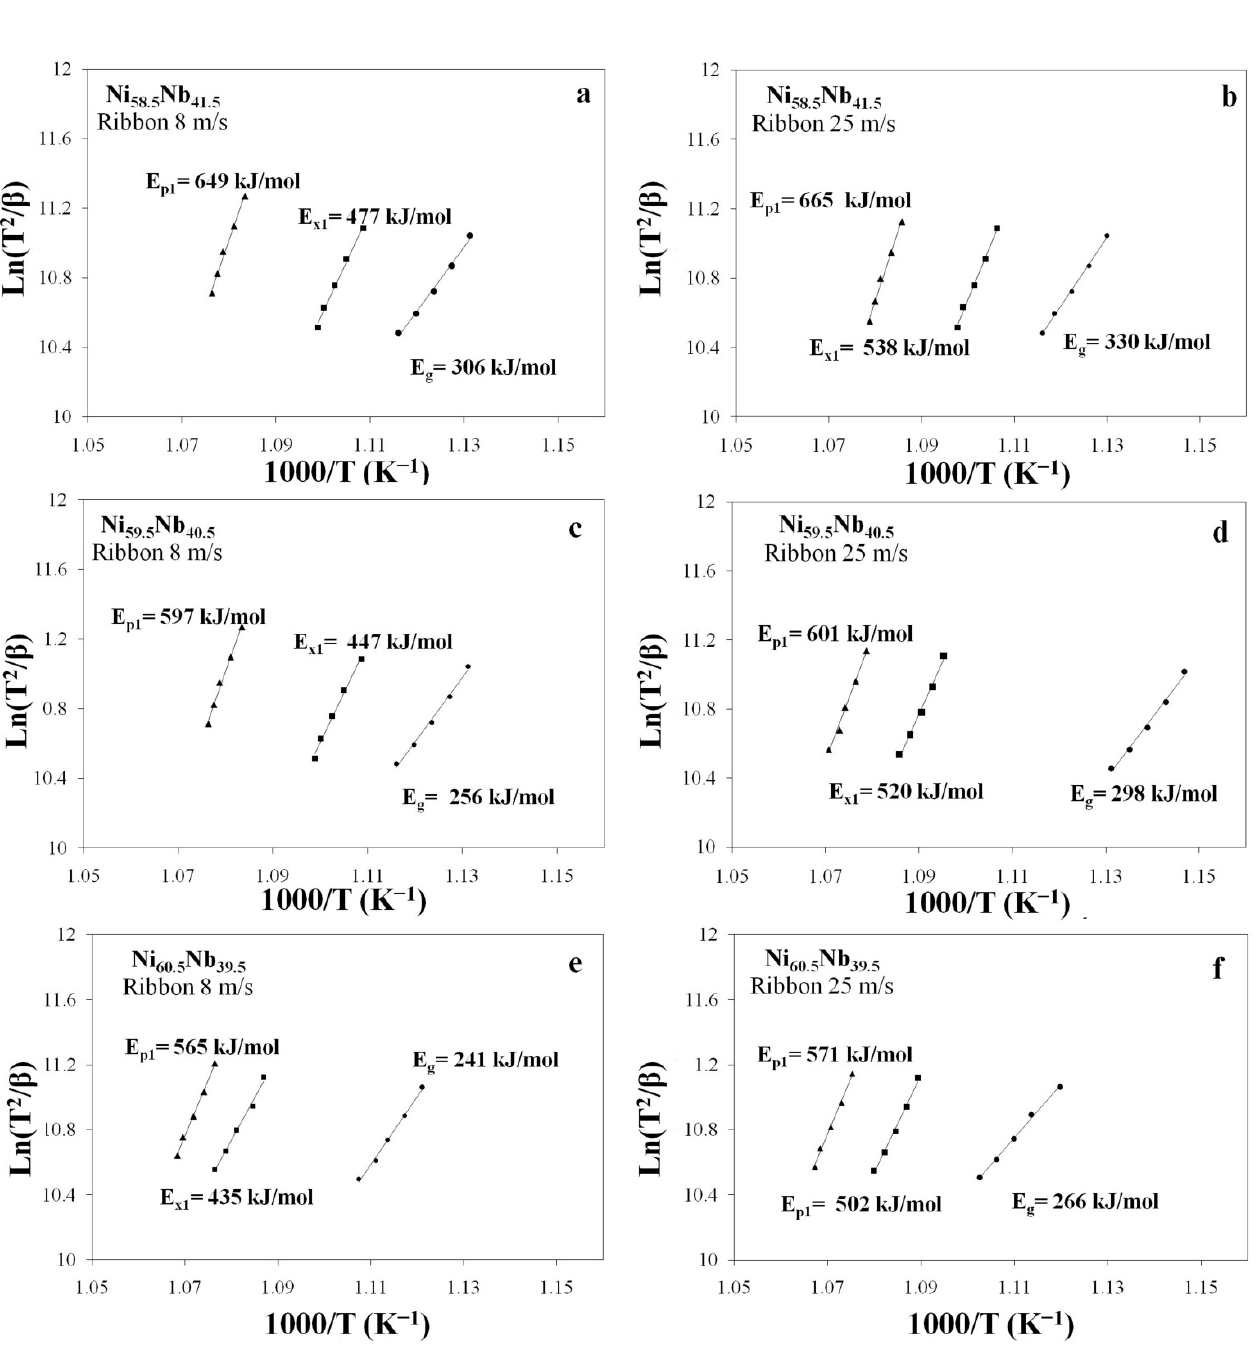
Figure 5. ( a – f ) . Kissinger plots of Ln ( β /T 2 ) vs. 1000/T (T = T g , T x1 and T p1 ) from 8 m/s ( a , c , e ) and 25 m/s ( b , d , f ) ribbons of Ni 58.5 Nb 41.5 , Ni 59.5 Nb 40.5 and Ni 60.5 Nb 39.5 alloys.